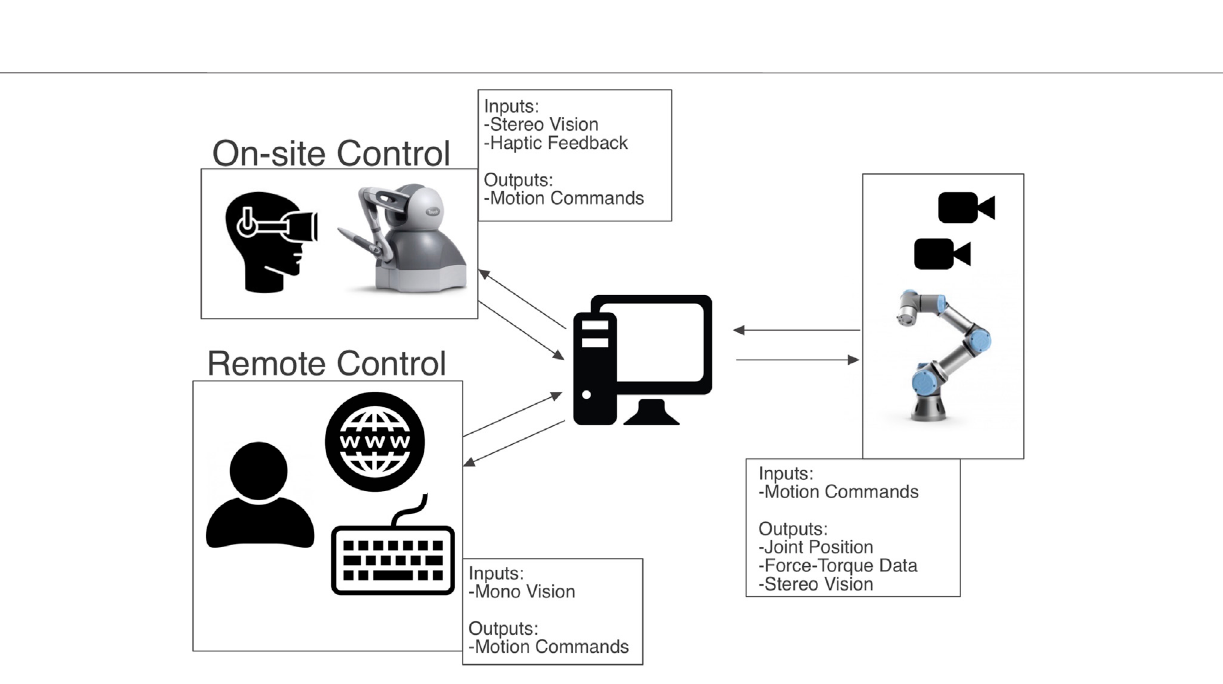
FIGURE 2 | Overall system architecture